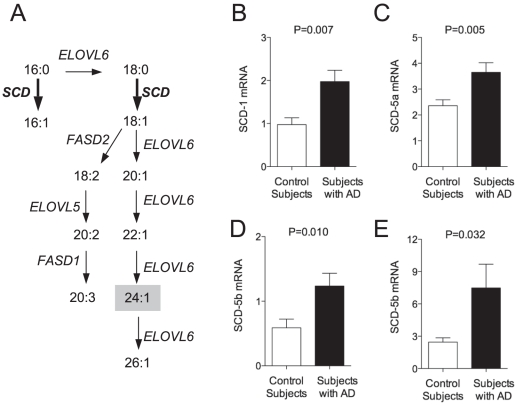
Overview of MUFAs biosynthesis and levels of SCD mRNA in the brain of subjects with AD and control subjects.Palmitic acid (16:0) is transformed into palmitoleic acid (16:1n-7) by the action of SCD (Panel A). Palmitic acid can also be transformed into stearic acid (18:0) by elongase activity (such as those encoded by ELOVL genes) and subsequently into oleic acid (18:1) by SCD activity (Panel A). Oleic acid can be then converted into longer chain fatty acids by sequential action of elongases and Δ5 and Δ6 desaturases (encoded by the FASD1 and FASD2 genes, respectively, Panel A). Levels of mRNA for SCD-1 (Panel B), SCD-5a (Panel C) and SCD-5b (Panel D) in hippocampus and SCD-5b (Panel E) in mid-frontal cortex from control subjects (N = 17, open squares) and AD patients (N = 28, closed circles). Two-tailed Welch's t-test.